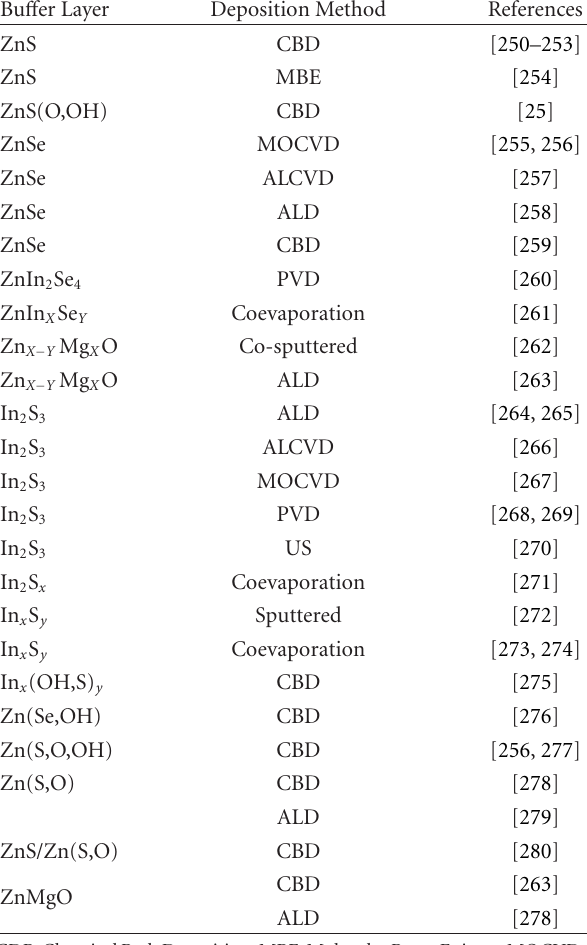
Table 2: Alternative bu ff er layers and their deposition methods. Bu ff er Layer